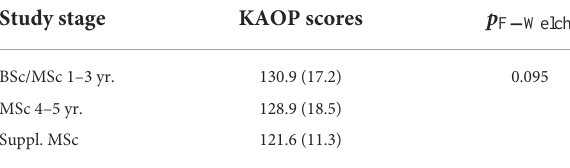
TABLE 7 The KAOP scores grouped by age study stage, N =